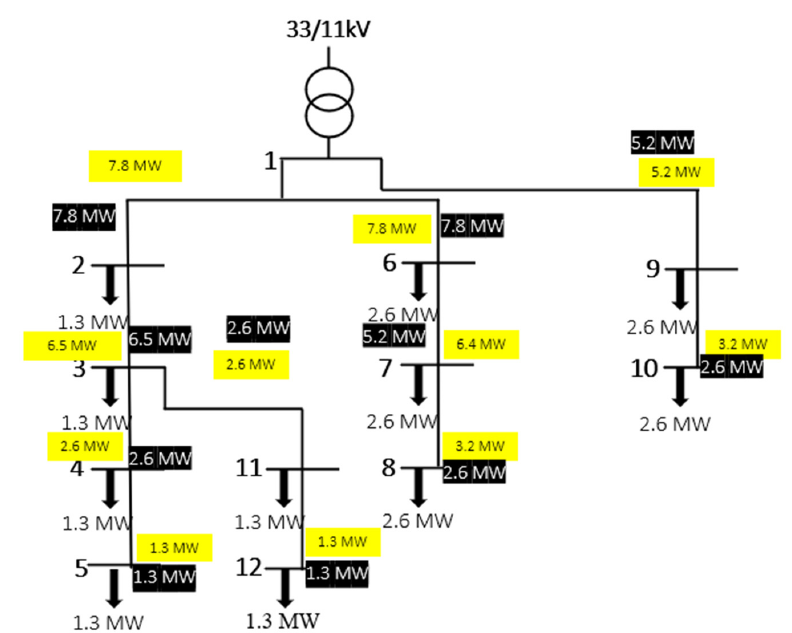
Figure 8. Schematic diagram of the HV electricity grid showing the initial line thermal limits (in black), and the second-stage peak load (downward black arrows) assuming that in the second stage scenario 𝑆 (cid:2870) has occurred (i.e., 50% load growth at every bus) and that EV smart charging, with flexibility = 40%, has been deployed for all EVs in the system i.e., at every bus in the system. Moreover, the second stage power flows are shown (in yellow) ignoring thermal line limits. The expected cost for decision 𝐷 (cid:2871) is 𝐸 (cid:2871) = 𝑝 (cid:2869) 𝐶 (cid:2869)(cid:2871) + 𝑝 (cid:2870) 𝐶 (cid:2870)(cid:2871) + 𝑝 (cid:2871) 𝐶 (cid:2871)(cid:2871) = 0.4 × £331,428 + 0.35 × £45,714 + 0.25 × £0 = £148,571 . Regarding the cost of stranded assets, this is zero since there are no stranded assets given the zero delay for smart charging.